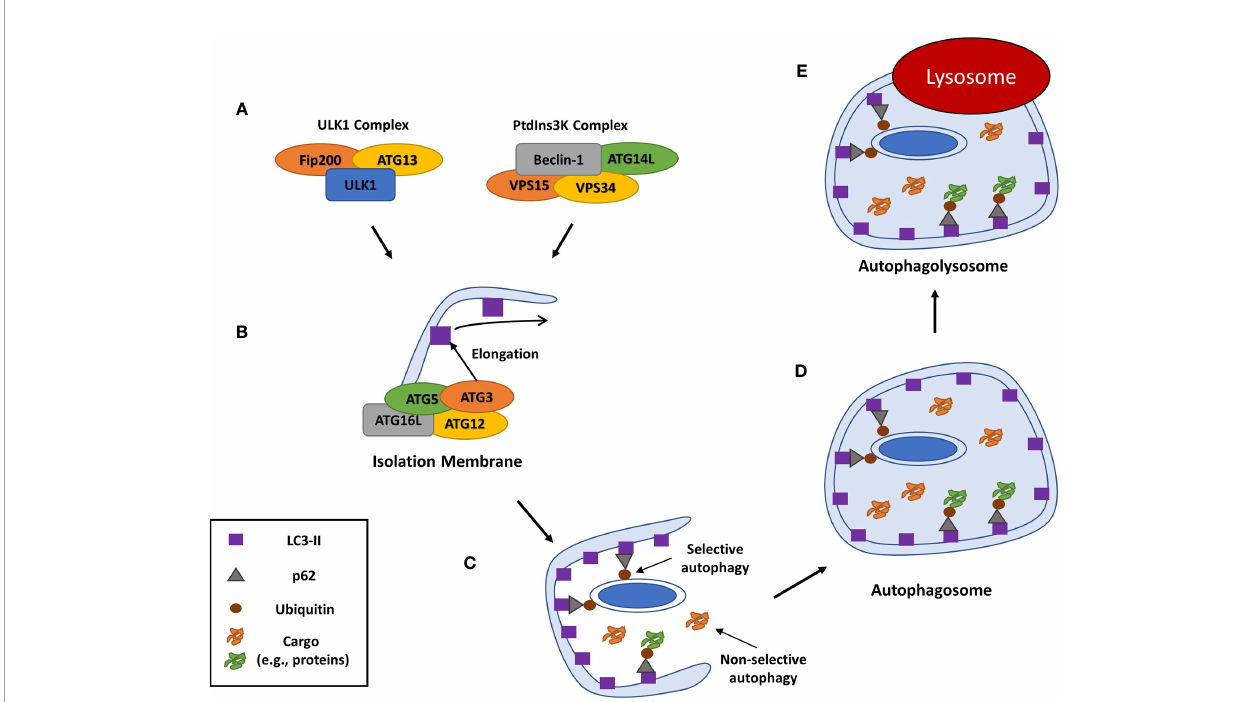
FIGURE 1 | Overview of mammalian autophagy. Autophagy is induced through the recruitment of numerous autophagy related proteins (ATGs) to a speci fi c cytoplasmic location. This is followed by the formation of the isolation membrane that eventually elongates and closes around organelles or cell debris to be digested to form a double-membraned phagosome, or autophagosome (46). (A) The autophagic cascade is initiated by core molecular machinery including the Ulk1 complex and an activation complex comprising of Beclin-1, the class III PI3-kinase, Vacuolar protein sorting 34 (VPS34), ATG14L and VPS15 (47). (B) This complex facilitates the de novo formation of an isolation membrane that then elongates to form a double membraned phagophore, by recruiting several ATGs, including ATG3, ATG16L and the ATG-12-ATG5 complex, which then convert the ATG8 protein LC3-I to its lipidated, membrane-bound form LC3-II (48). (C) As well as non-selective autophagy of cytoplasmic components, cargo can be speci fi cally recognized and marked for autophagy typically by ubiquitination. Ubiquitinated cargo is then recognized by cargo receptor molecules including SQSTM1/p62, CALCOCO2 and OPTN and traf fi cked to the phagophore through an interaction between the cargo receptor and LC3 (49 – 51). (D) Continued LC3-II conjugation to the phagophore causes it to elongate and form a cargo containing autophagosome which is traf fi cked to the host lysosome. (E) The autophagosome matures and fuses with a lysosome, the autophagic cargo is degraded and the nutrients are released back into the cytosol to be re-used by the